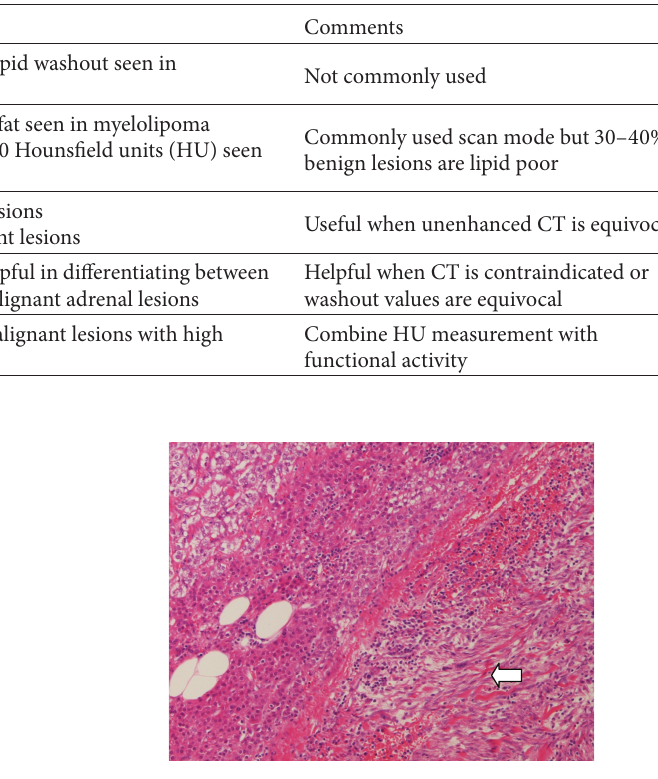
Figure 2: Microscopic appearances of the leiomyosarcoma on the right (solid white arrow) and normal adrenal gland on the left (haematoxylin and eosin staining). The cells were strongly positive for smooth muscle actin and desmin on immunostaining (not